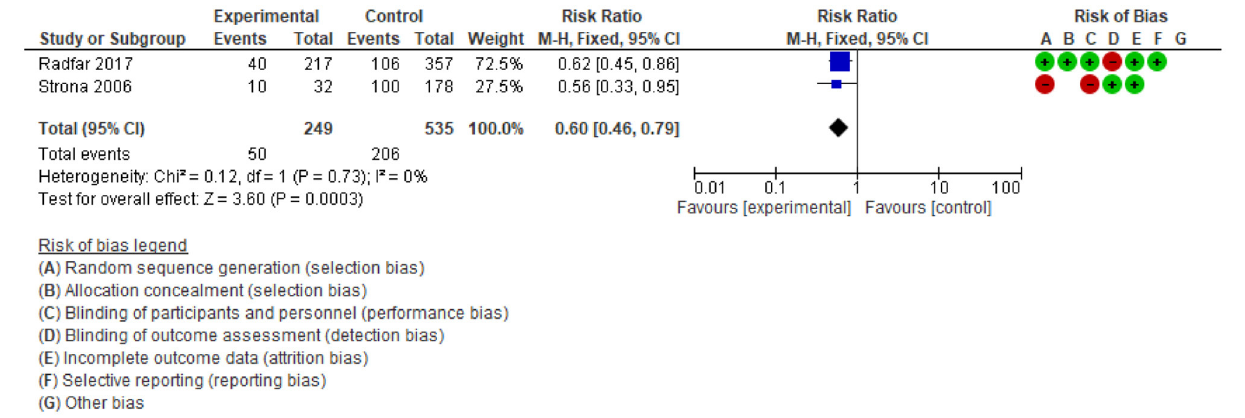
FIGURE 8 | Comparison of unsafe sex risk behaviours by